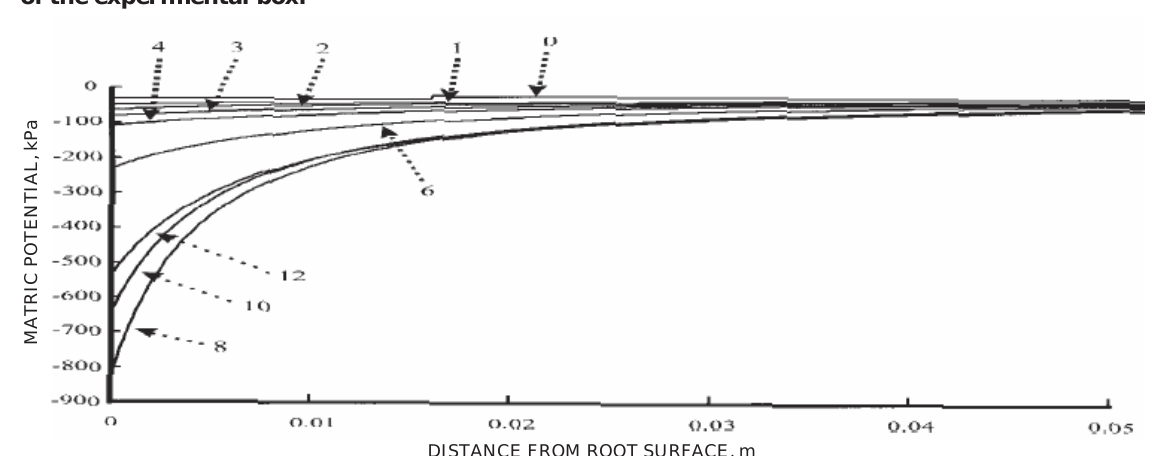
Figure 4. Example of measured soil water contents (dots) and model estimates after fitting to equation 16 (line) for observations made 10 days after the water supply was stopped, at 0.04 m depth, in both sides of the experimental box.